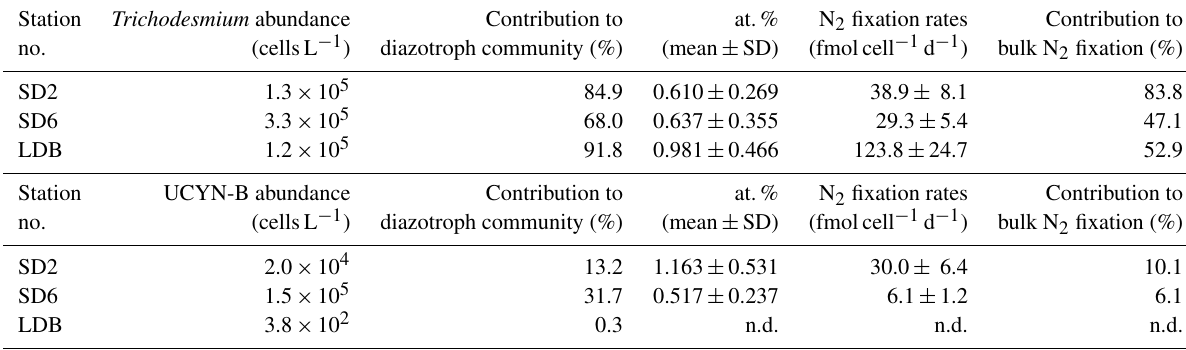
Table 3. Summary of diazotroph abundances and nanoSIMS analyses at SD2, SD6 and LDB. Station Trichodesmium abundance Contribution to at.% N 2 fixation rates